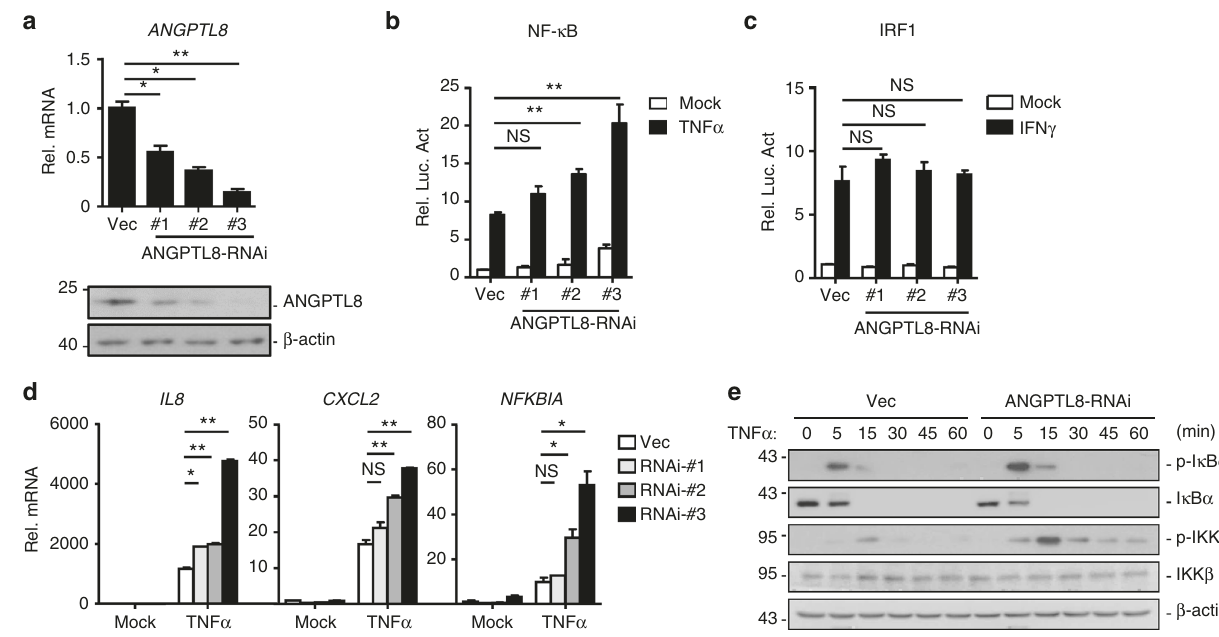
Fig. 2 Knockdown of ANGPTL8 potentiates TNF α -induced NF- κ B activation. a Ef fi cacy of three different ANGPTL8-RNAi plasmids on the transcription (upper panels) and expression (lower panels) of ANGPTL8 in the control or shANGPTL8 stable HepG2 cell lines ( n = 3). b Effects of ANGPTL8-RNAi on TNF α -induced NF- κ B activation in the cell lines indicated as in a ( n = 3). c Effects of ANGPTL8-RNAi on IFN γ (100 ng/mL) induced IRF1 activation ( n = 3). d Effects of ANGPTL8-RNAi on TNF α -induced IL8 , CXCL2 and NFKBIA transcription for 2 h in cell lines indicated as in a ( n = 3). e Effects of ANGPTL8-RNAi on TNF α -induced IKK and I κ B α phosphorylation in ANGPTL8-RNAi-#3 or control cells in a . Data are shown as the mean ± SEM, unpaired two-tailed Student ’ s test was used for statistics ( a – d ), * p < 0.05, ** p < 0.01, NS > 0.05. Data are representative of three independent